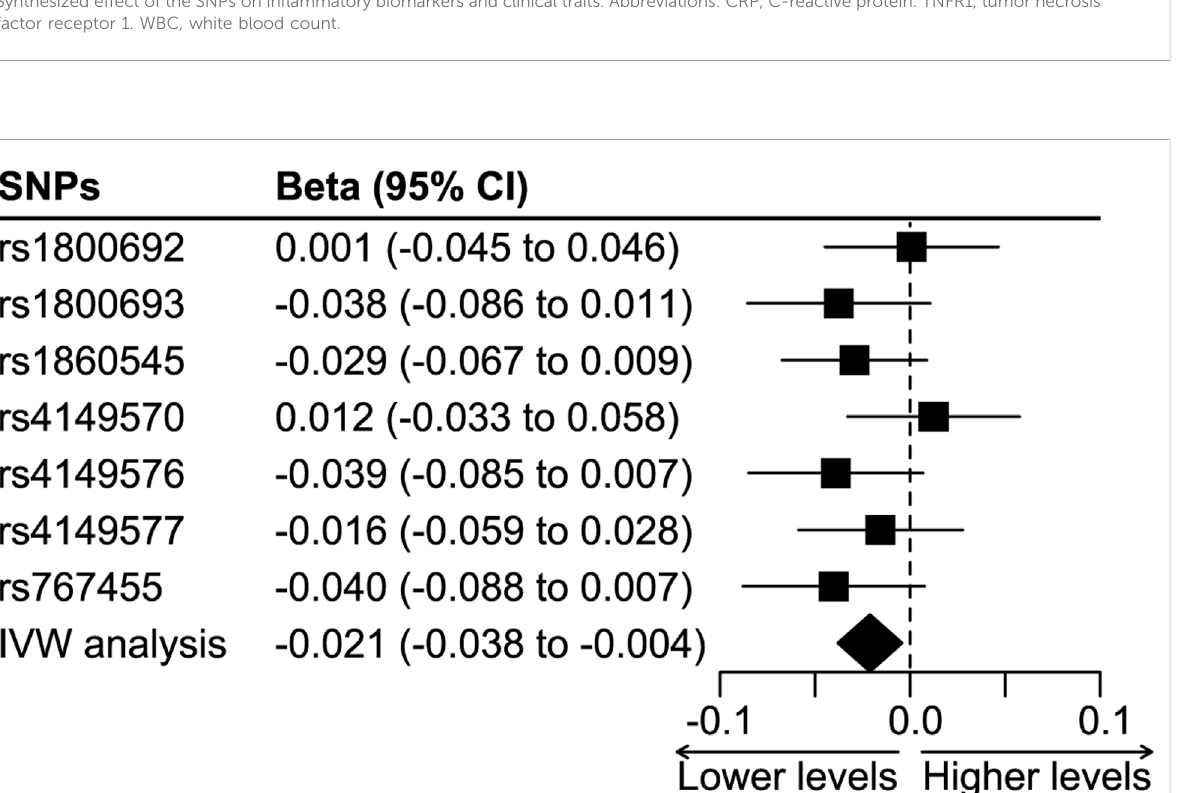
FIGURE 4 The effect of TNF-inhibition on the risk of colorectal cancer. Abbreviations: IVW analysis, inverse-variance weighted analysis. SNP, single nucleotide polymorphism. Footnotes: The IVW analysis showed a signi fi cant protective effect of TNF inhibition on colorectal cancer, and it was associated with an absolute risk reduction of 2.1% (95%CI 0.4% to 3.8%) per 1-mg/L reduction in CRP